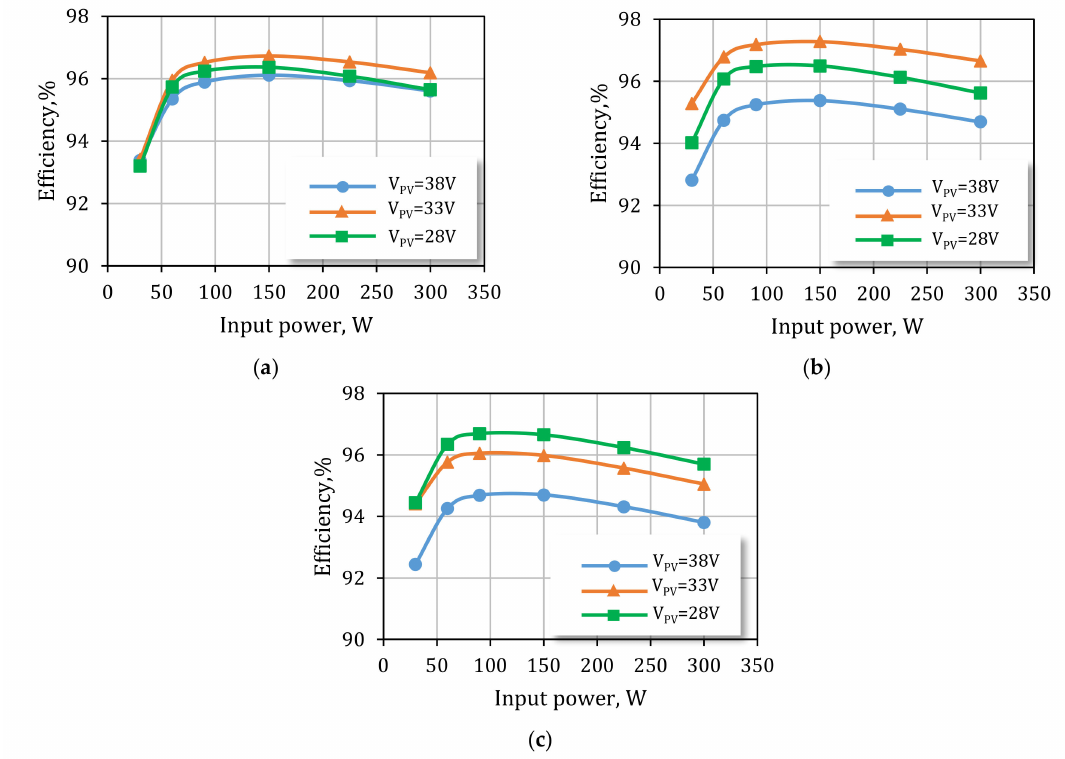
Figure 8. Comparison of estimated e ffi ciencies of the converter for the turns ratio of: ( a ) n 1 = 5.7, ( b ) n = 6.1, and ( c ) n 2 =